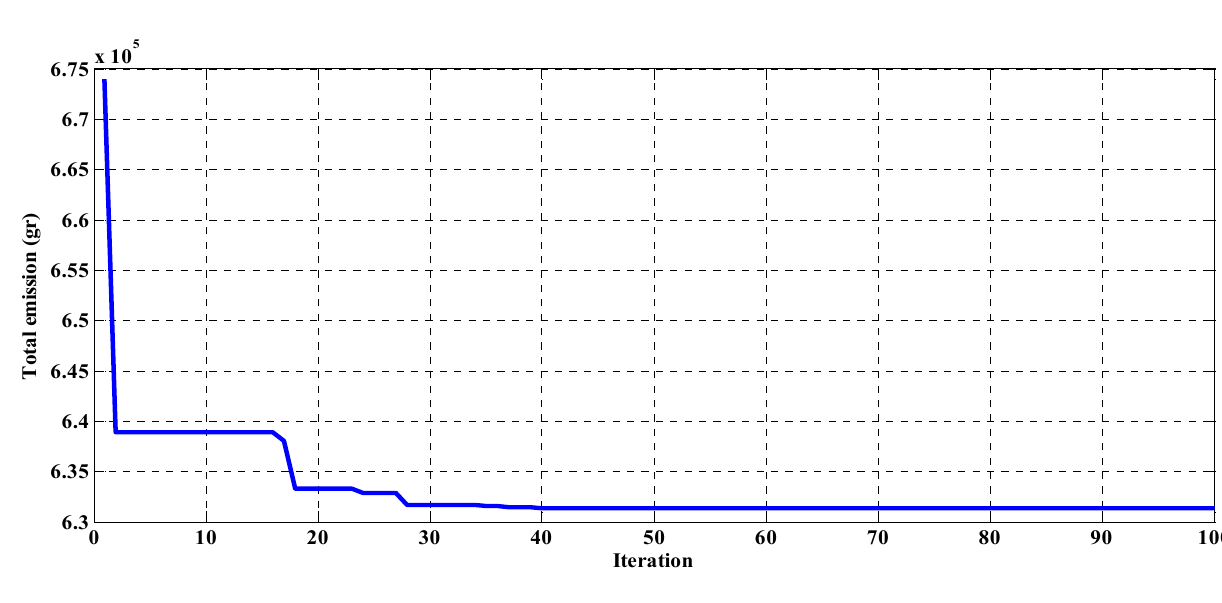
Figure 8. Convergence plot of FAMPSO for emission function.